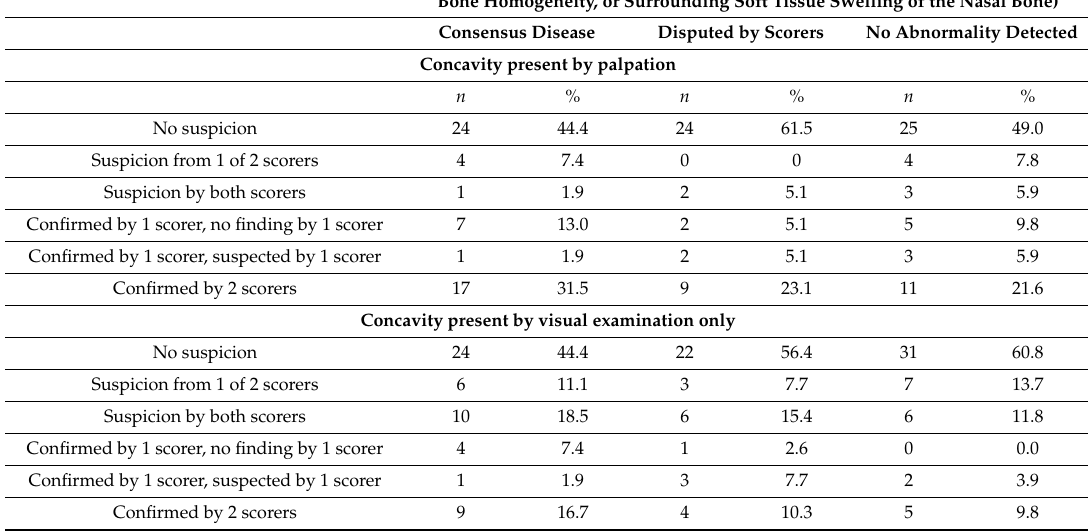
Table 4. Relationship between any radiographic lesion being noted and the concavity physical examination findings of the nasal bones of 144 horses.